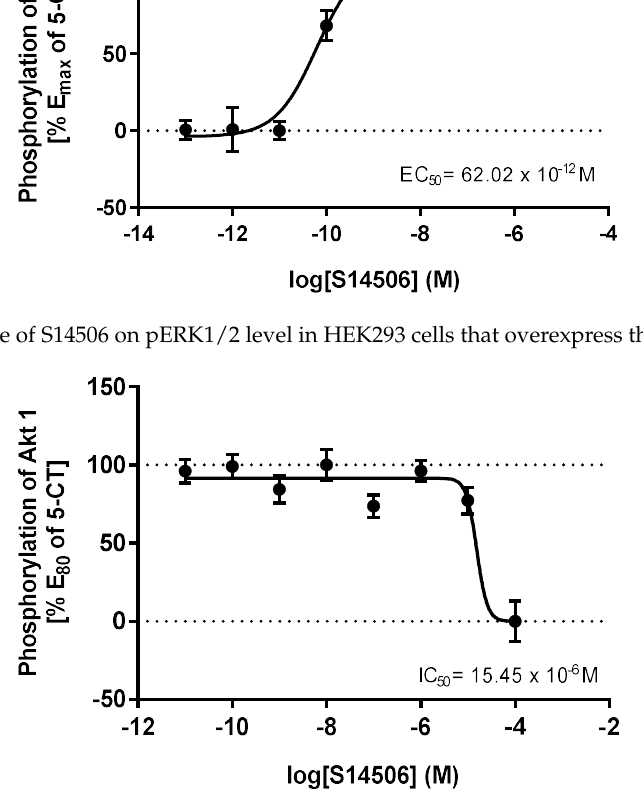
Figure 7. Influence of S14506 on pAkt level in HEK293 cells that overexpress the 5-HT1AR gene.